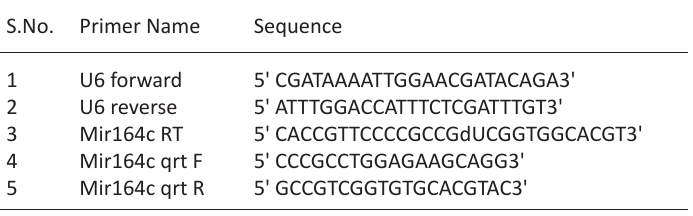
Table 1. List of primers used in the study